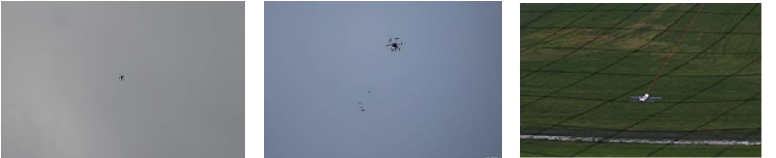
Figure 3. Some samples of challenges related to the small size of drones at long distances.